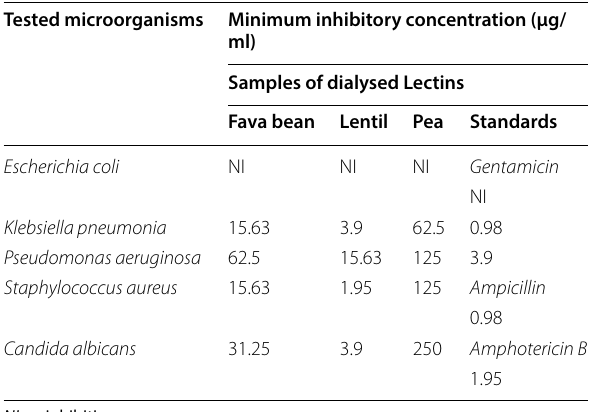
Table 5 Minimum inhibitory concentration (MIC) using series of two-fold dilutions of lectins (fraction 90%) of three leguminous seeds against the tested microorganisms Tested microorganisms Minimum inhibitory concentration (µg/